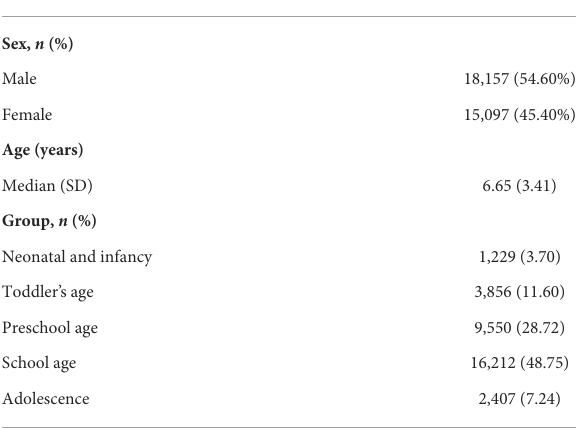
TABLE 1 Baseline characteristics of patients ( N = 33,254).